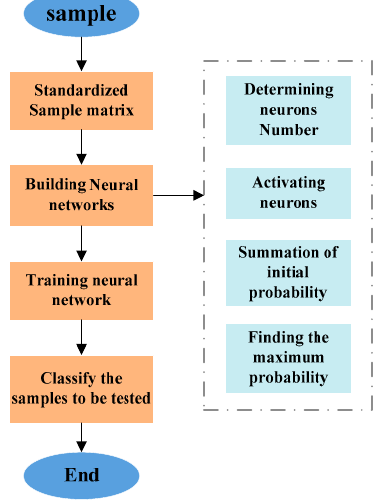
Figure 9. Flowchart of pattern recognition.